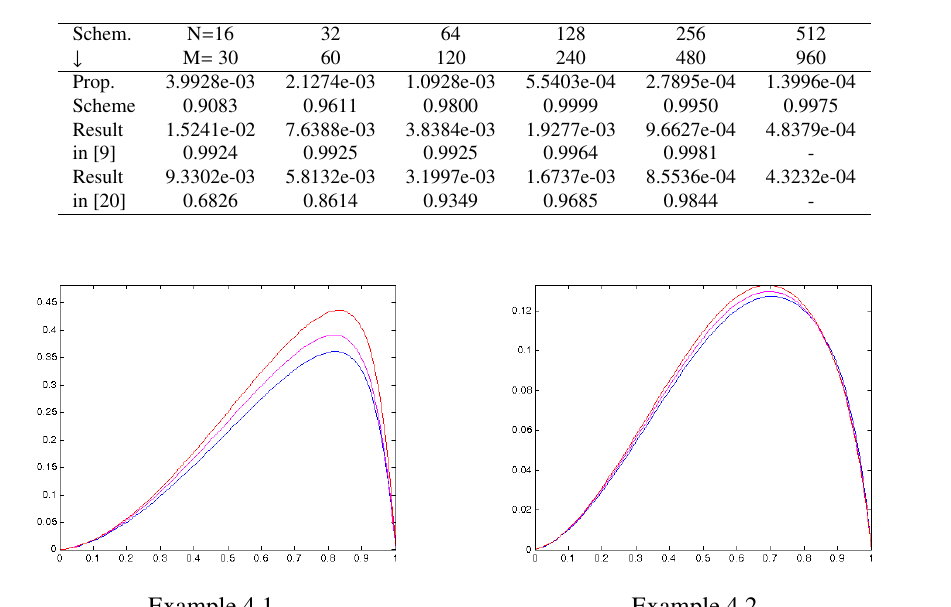
4, the Log-Log plot of the maximum absolute error verses N are given for singular